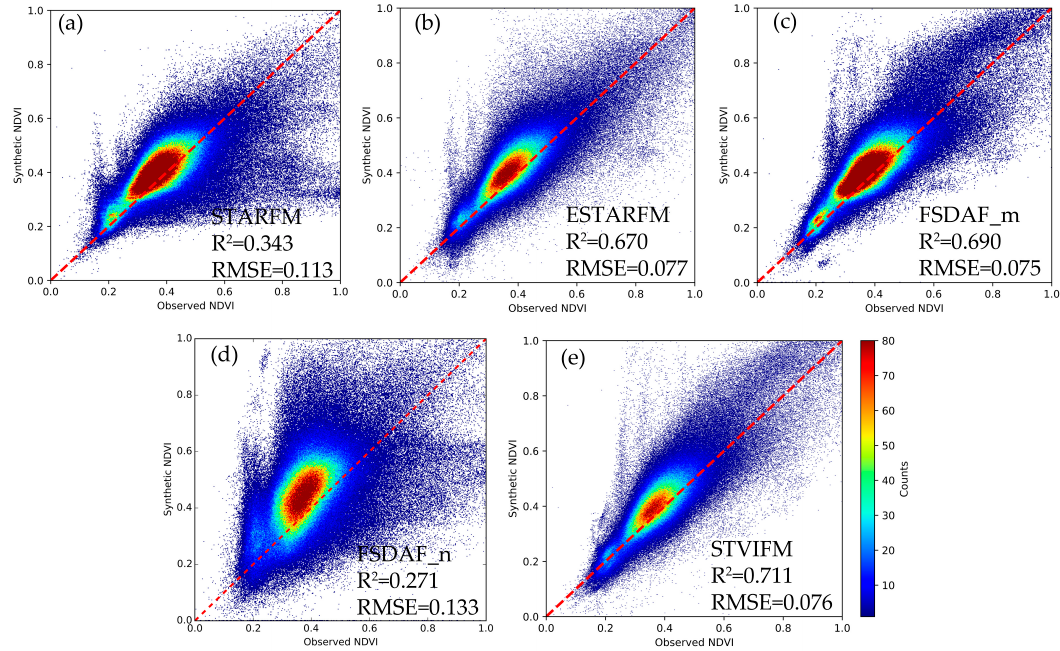
Figure 12. Scatter plots of observed and synthetic Landsat NDVI by: STARFM ( a ); ESTARFM ( b ); FSDAF_m ( c ); FSDAF_n ( d ); and STVIFM ( e ) in Kansas, U.S.